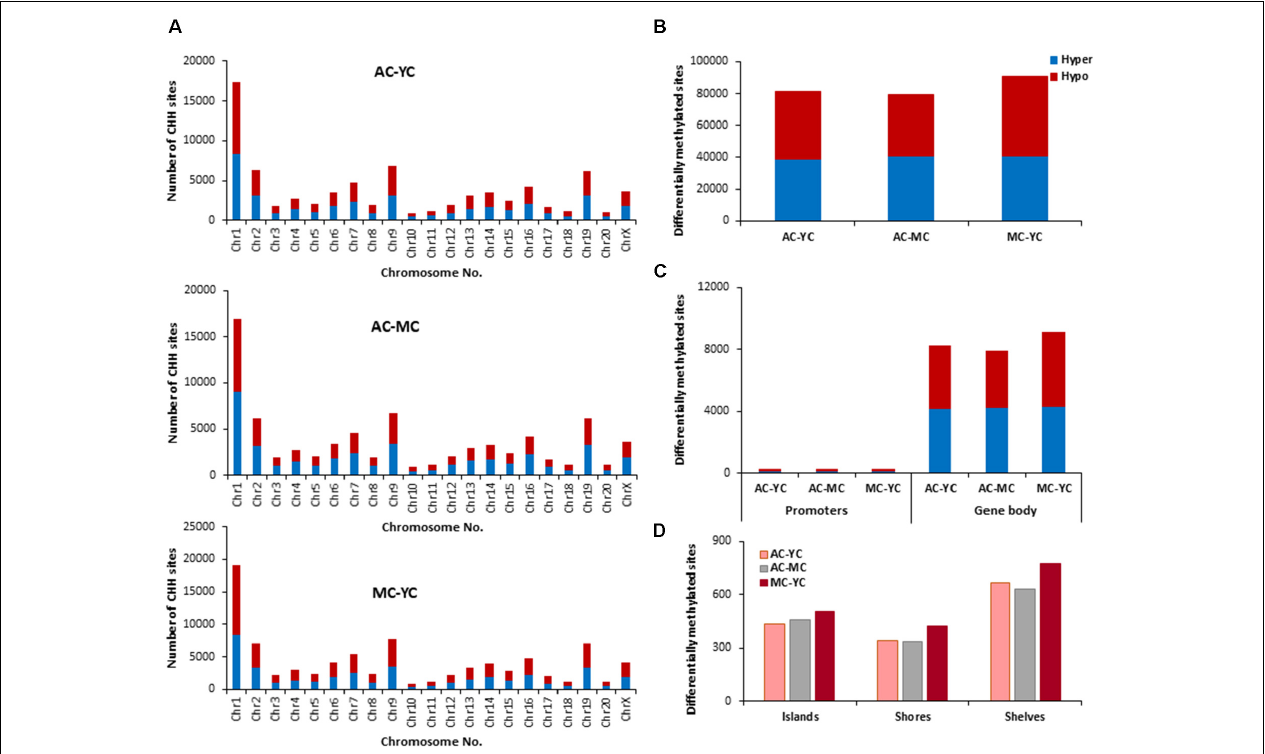
FIGURE 6 | Age-related differences in DNA methylation at CHH sites of control animals. (A) Differentially methylated CHH sites along the chromosome (1–20) including X-chromosome. The differential methylation was based on a statistical significance of p < 0.01. (B) Total number of differentially methylated CHH sites across the control groups. The red bars denote hypomethylation and blue bar denotes hypermethylation for the older group relative to the younger group. (C) Age differences in the number of differentially methylated CHH sites in promoter and gene body regions. (D) Comparison of the differentially methylated CHH sites across the regulatory regions: islands, shores, and